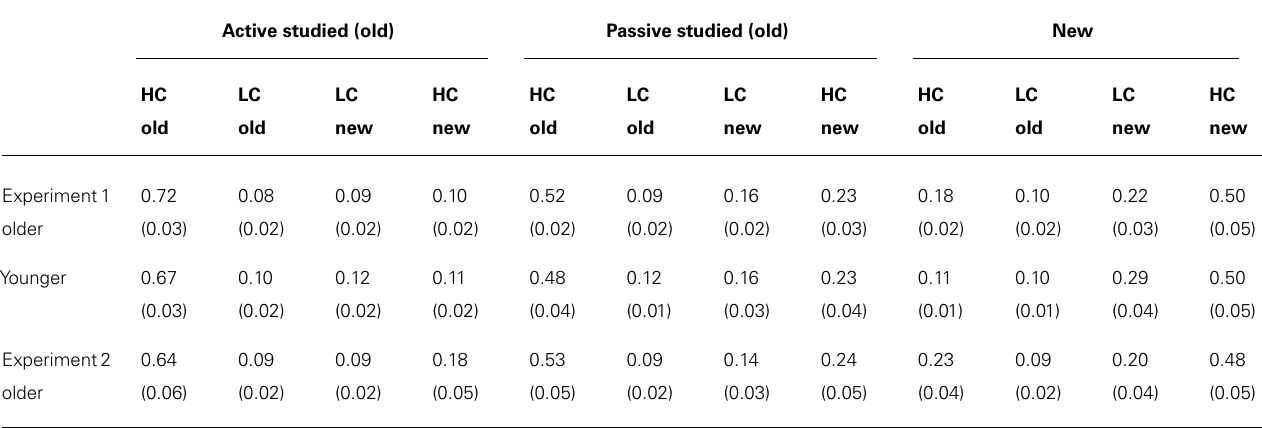
Table 1 | Mean and standard error for object recognition confidence ratings in Experiment 1 and Experiment 2. Active studied (old) Passive studied (old)